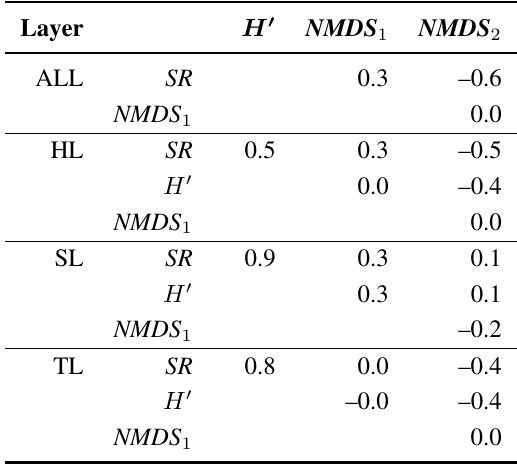
Table 1. Kendall’s τ rank order correlation between response variables species richness ( SR ), Shannon index ( H (cid:48) ), first and second NMDS axis scores ( NMDS ) for herb (HL), shrub (SL), tree (TL) layer and their total (ALL). Diagonals are not displayed. For the presence-absence scaled layer composite ALL H (cid:48) could not be calculated.